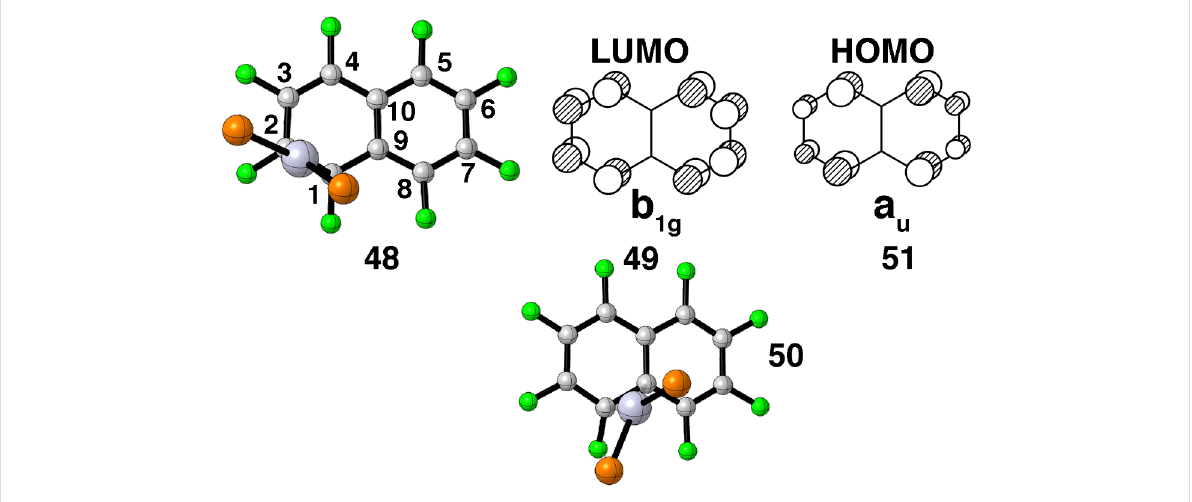
Figure 14: A top view of two stationary points found for F 8 C 10 –Pt(dpe); 48 is the ground state and 50 , represents one point on the plateau. The LUMO and HOMO in naphthalene are drawn in 49 and 51 , respectively.